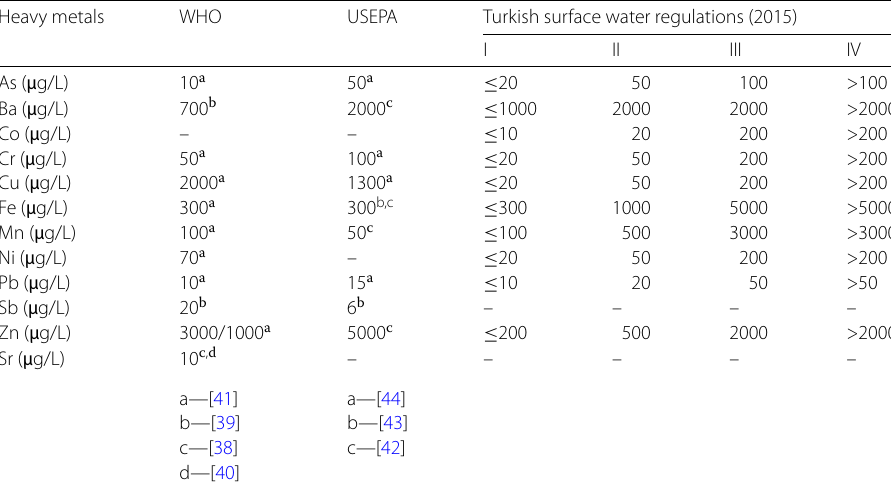
Table 2 Permissible limits for surface waters according to standards of the World Health Organization [38–41], United States Environmental Protection Agency [42–44], and Turkish Standard Institute surface water regulations